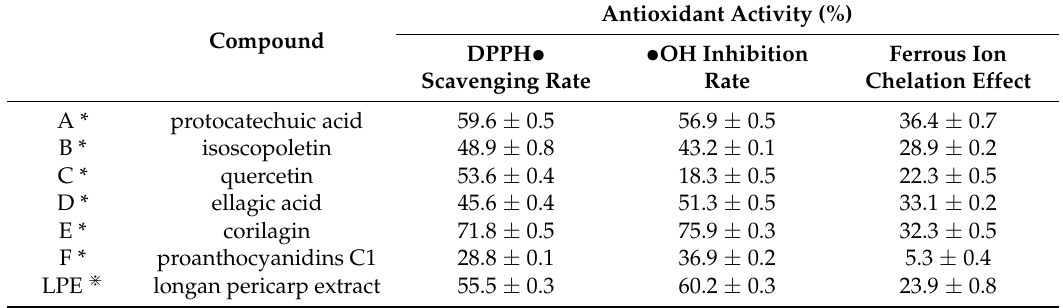
Table 1. Antioxidant activities of longan pericarp phenols (LPPs) and purified longan pericarp extract (LPE) ( n = 3).